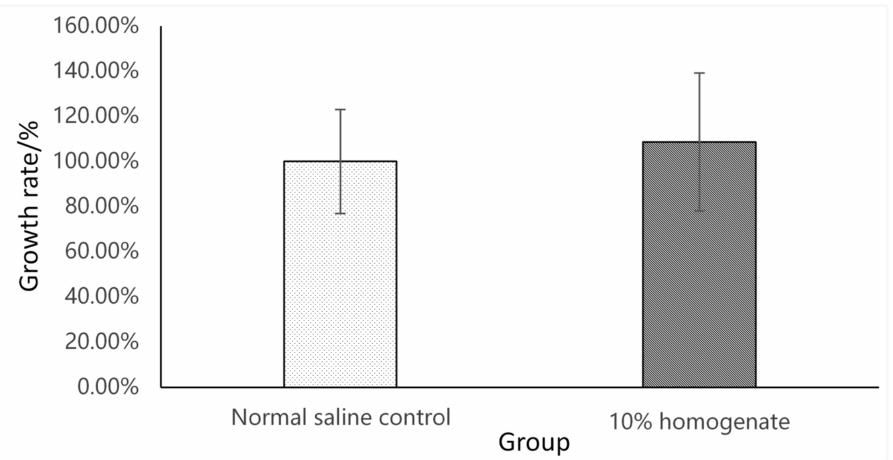
Figure 1. Comparison between the growth rate of L. casei in the normal saline control and 10% GI tract homogenate ( n = 9) on the MRS plate.